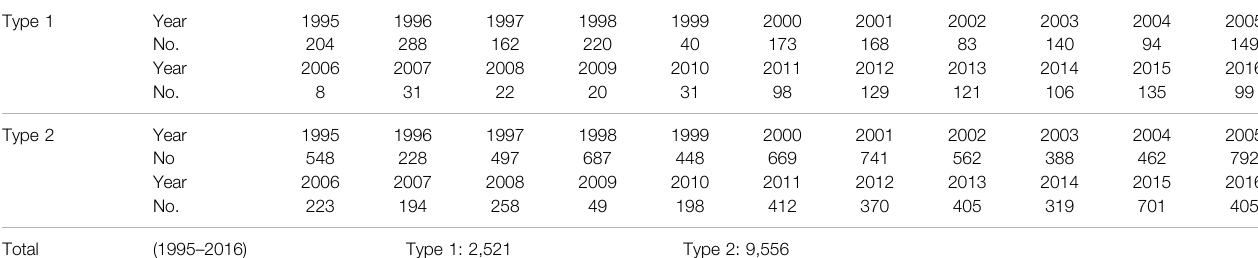
TABLE 1 | List of Solar Wind Dynamic Pressure Pulses (DPPs) in the undisturbed solar wind and solar wind transients.